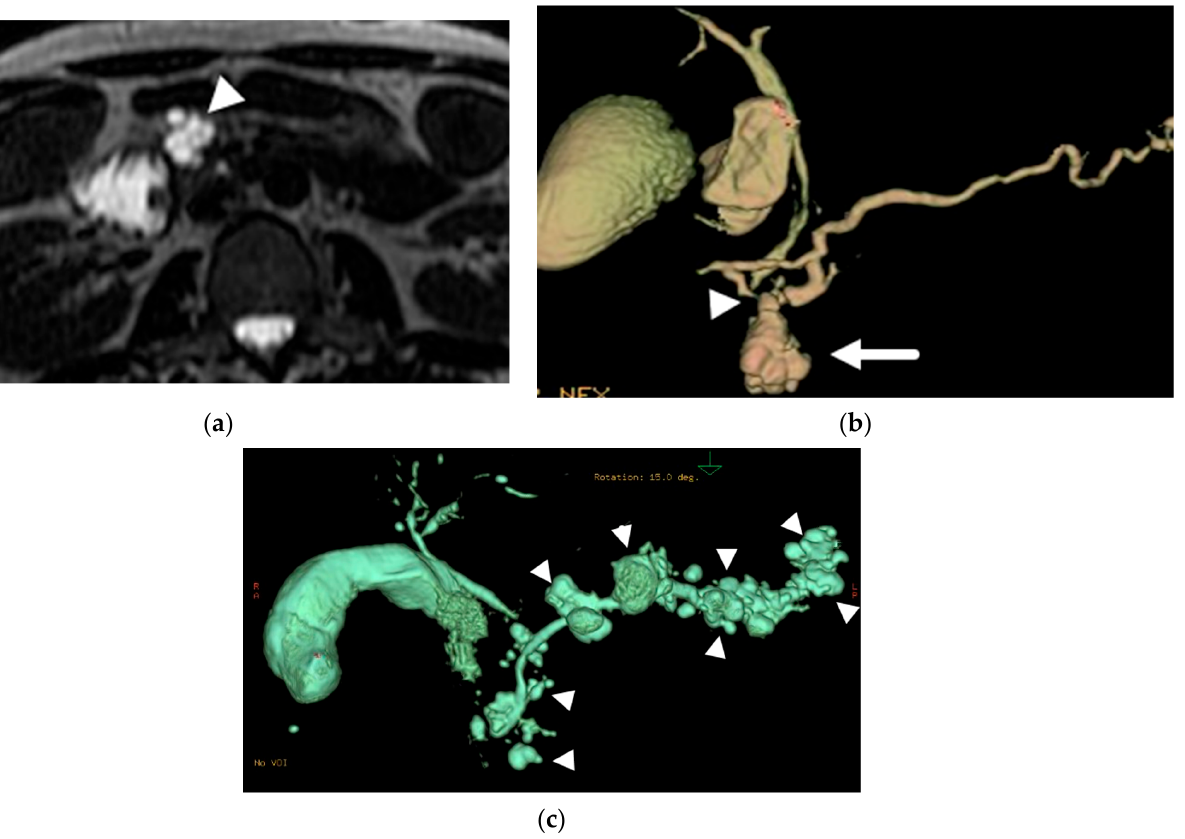
Figure 1. Branch duct IPMN. ( a ) Axial T2-weighted image demonstrates a multilocular cystic lesion in the pancreatic head (arrowhead). ( b ) Volume rendered image from MRCP demonstrates the bunch of grape appearance (arrow) with duct communication (arrowhead), confirming the diagnosis of BD-IPMN. ( c ) Volume rendered MRCP from another patient demonstrates numerous branch duct IPMNs throughout the gland (arrowheads).